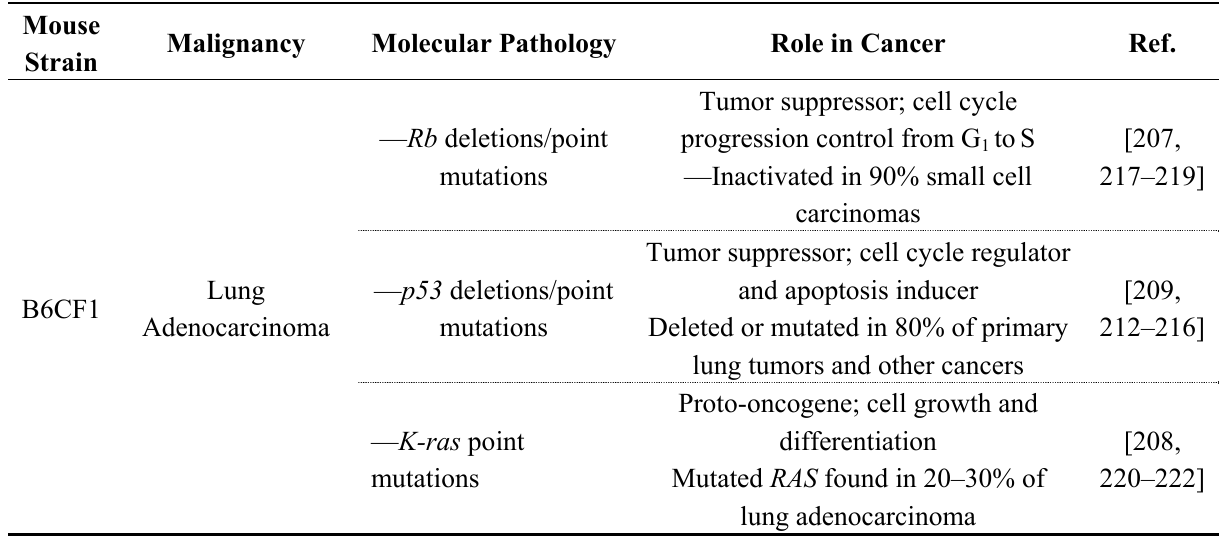
Table 5. Molecular pathologies associated with radiation-induced lung